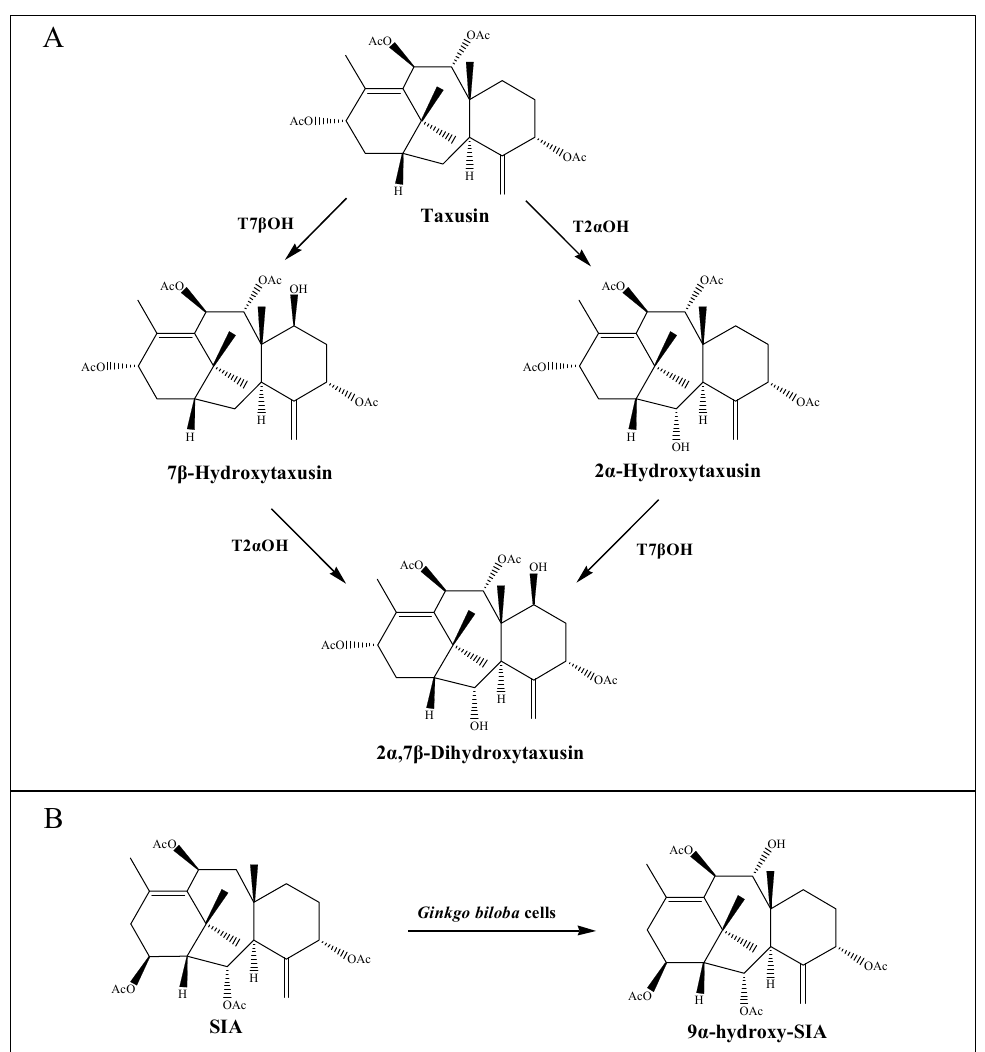
Figure 2. Putative intermediate steps of the taxol pathway. ( A ) T2 α OH- and T7 β OH-mediated hydroxylation reactions. ( B ) T9 α OH-mediated hydroxylation reaction in Ginkgo biloba cells. ( B ) T9 α OH-mediated hydroxylation reaction in Ginkgo biloba